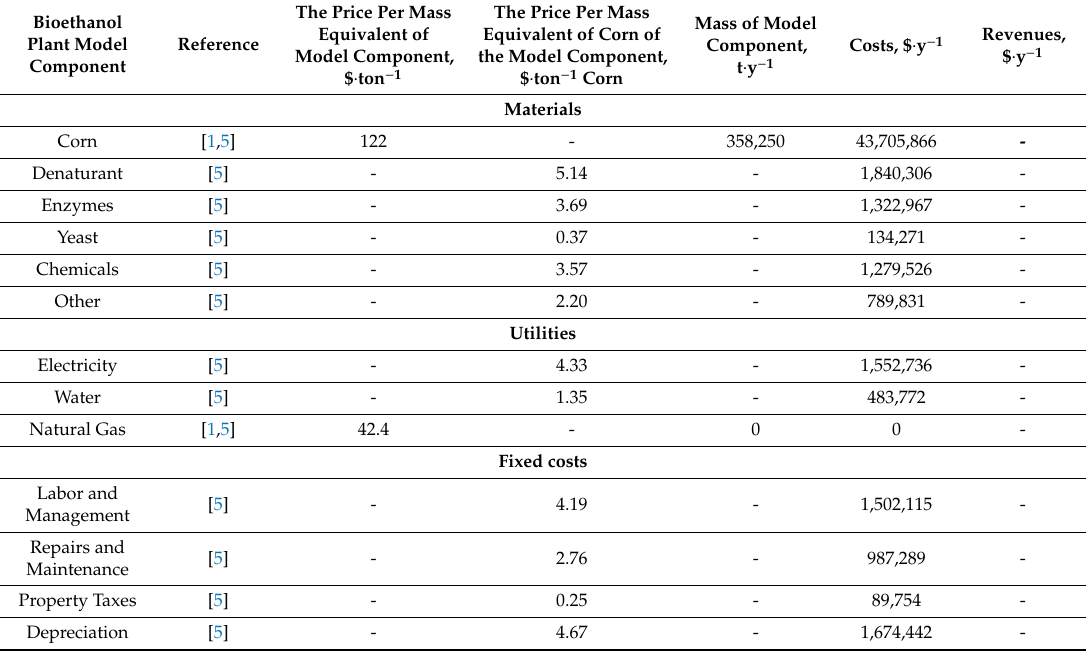
Table 3. The economic analysis of the bioethanol plant with implemented torrefaction of DDGS on the base of the mass balance of the main components and prices of the main component of the techno-economic model of bioethanol